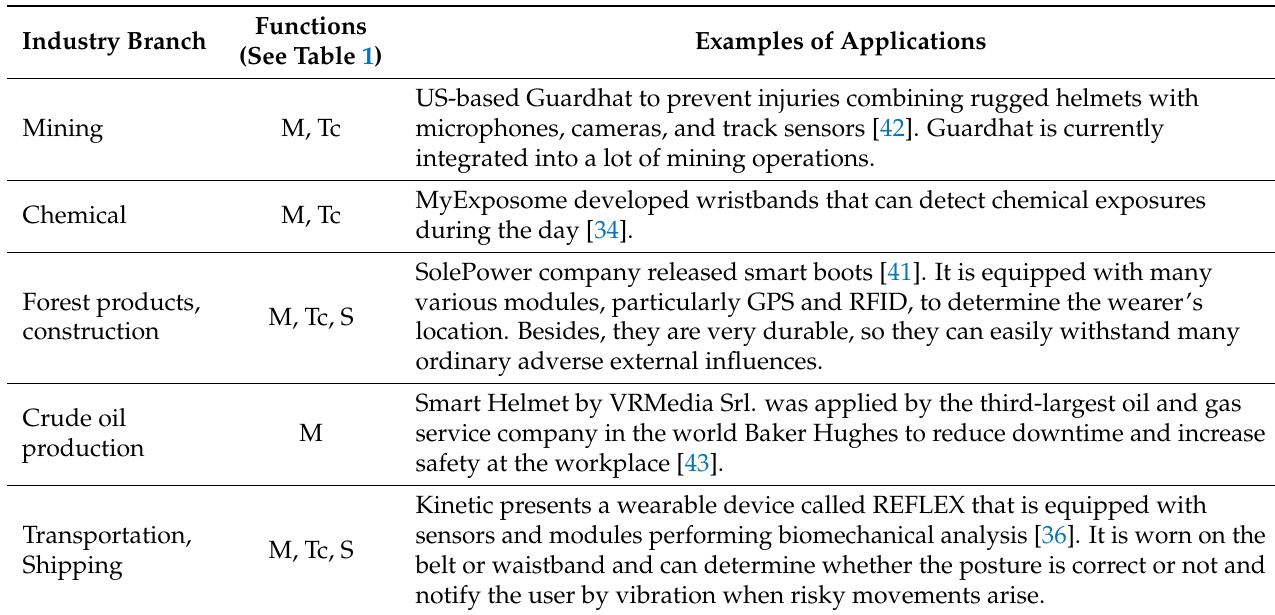
Table 2. Industry branches and inherent industrial wearable